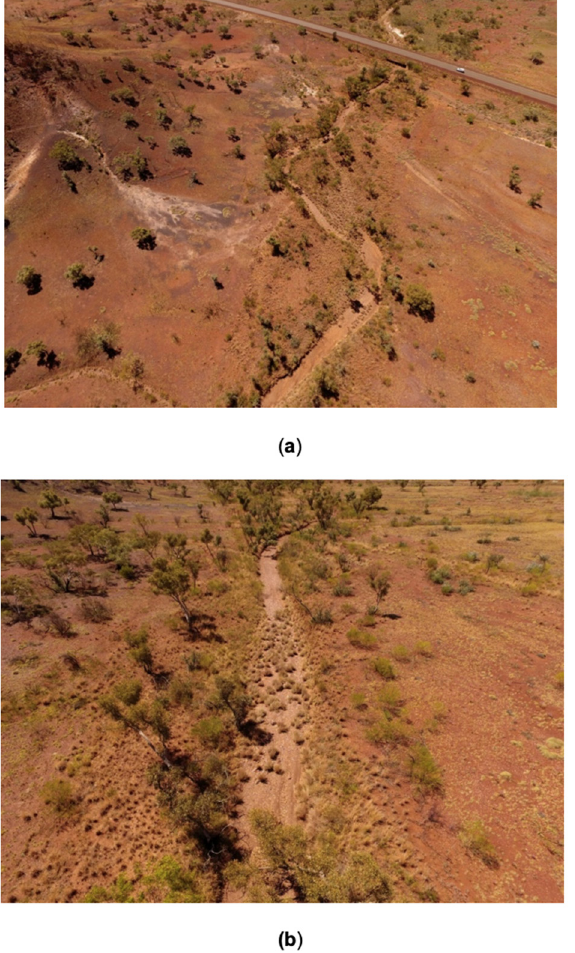
Figure 11. Examples of headwater channel surveyed, ( a ) vegetated headwater channel, ( b ) nascent in-channel vegetation increasing channel heterogeneity within a straight river reach.